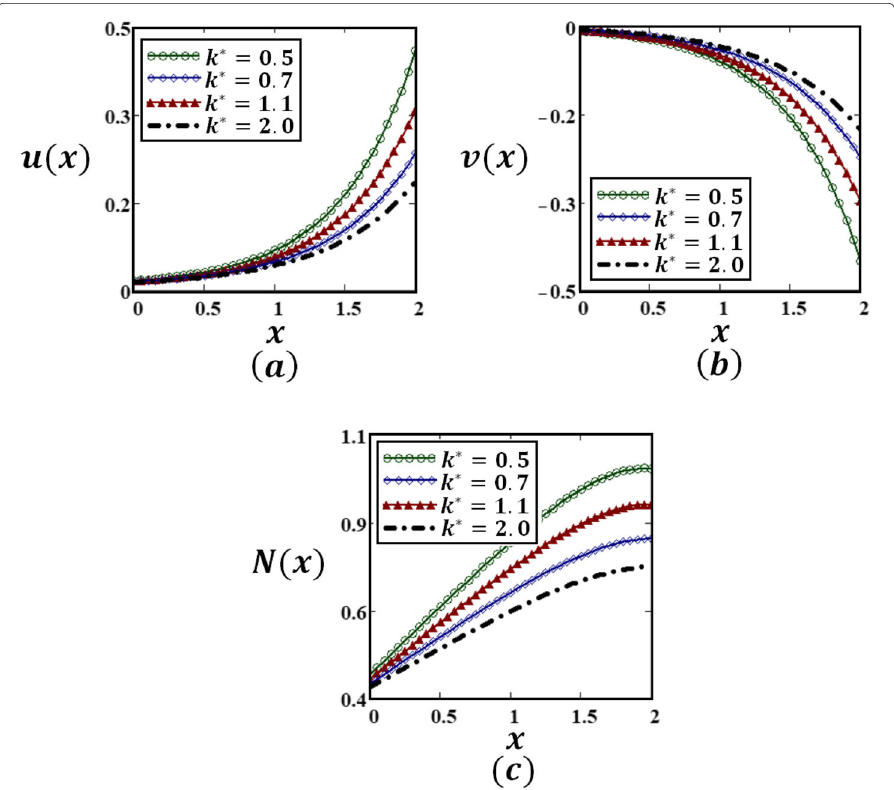
Fig. 8 Profiles of the velocity field u ( x , t ) , v ( x , t ) , and microrotation N ( x , t ) for MHD micropolar fluid given by Eqs. (32), (33), and (34), for U = 0.1, ν = 0.045, μ = 0.5, κ = 0.2, B 0 = 2, σ = 0.2, j = 0.03, m = n = 1, y = 1, c 0 = 0.01, t = 2 s , and different values of k